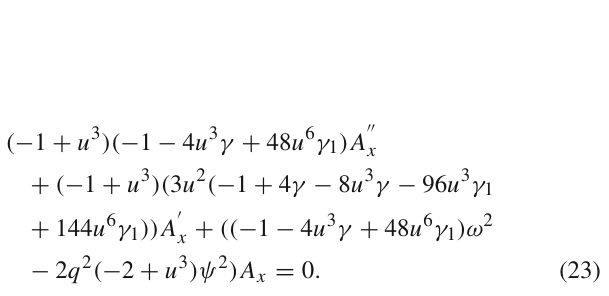
/ T c for different